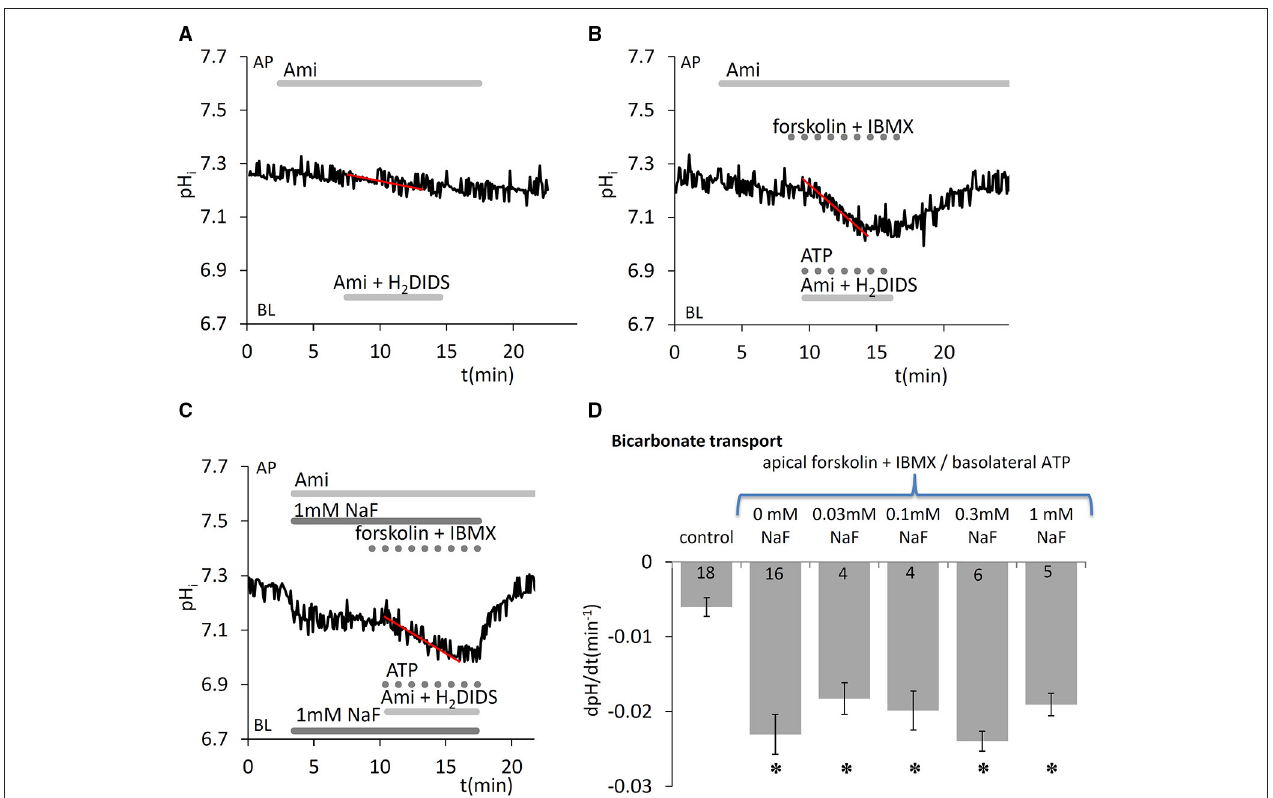
FIGURE 5 | Effects of fluoride on HCO − 3 secretion by HAT-7 cells stimulated with ATP and forskolin . Basolateral HCO − 3 uptake in HAT-7 cells grown on Transwell membranes was inhibited by simultaneous basolateral (BL) application of 500 µ M H2DIDS and 300 µ M amiloride (Ami). Amiloride was also included in the apical (AP) perfusate to inhibit any apical NHE activity. Representative pH i traces obtained (A) in unstimulated control conditions, (B) in cells stimulated with ATP (50 µ M), forskolin (10 µ M), and IBMX (500 µ M), and (C) in stimulated cells exposed to 1mM NaF. (D) Mean dpH/dt ± SEM values calculated from the initial rates of decrease in pH i in unstimulated cells (control) and cells stimulated with ATP, forskolin and IBMX, and pretreated with a range of NaF concentrations. * p < 0.05 compared with